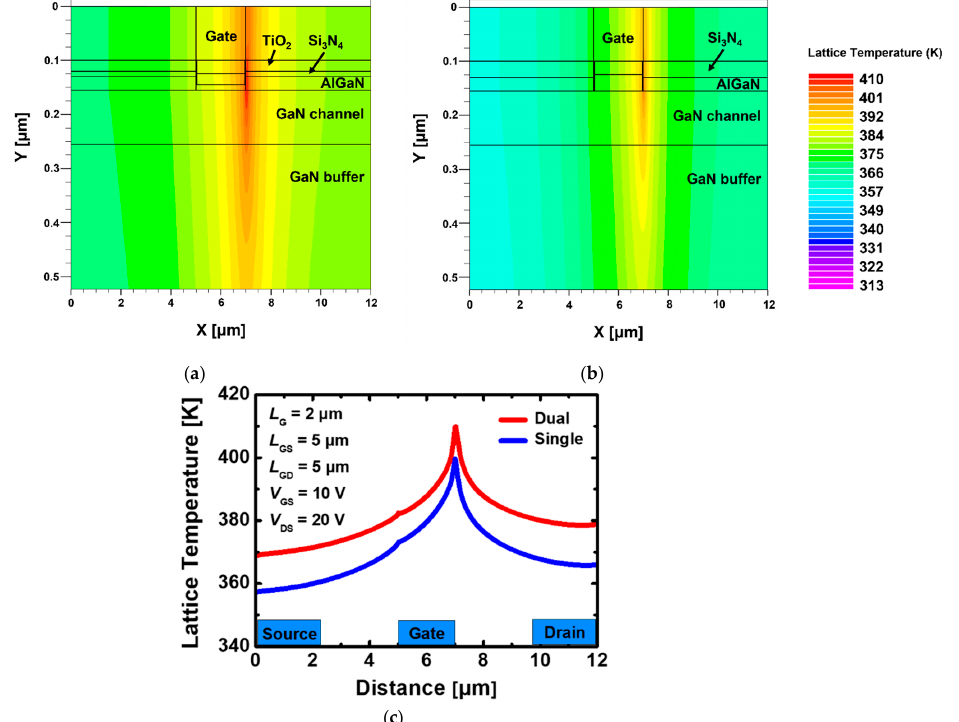
Figure 4. Cross-section of lattice temperature distribution in recessed-gate GaN MOSFET using ( a ) the stacked TiO 2 /Si 3 N 4 dual-layer insulator, ( b ) Si 3 N 4 single-layer insulator and ( c ) lattice temperature distribution according to AlGaN/GaN interface and channel layer for ( a , b ) when self-heating effect is applied at V DS = 20 V, V GS = 10